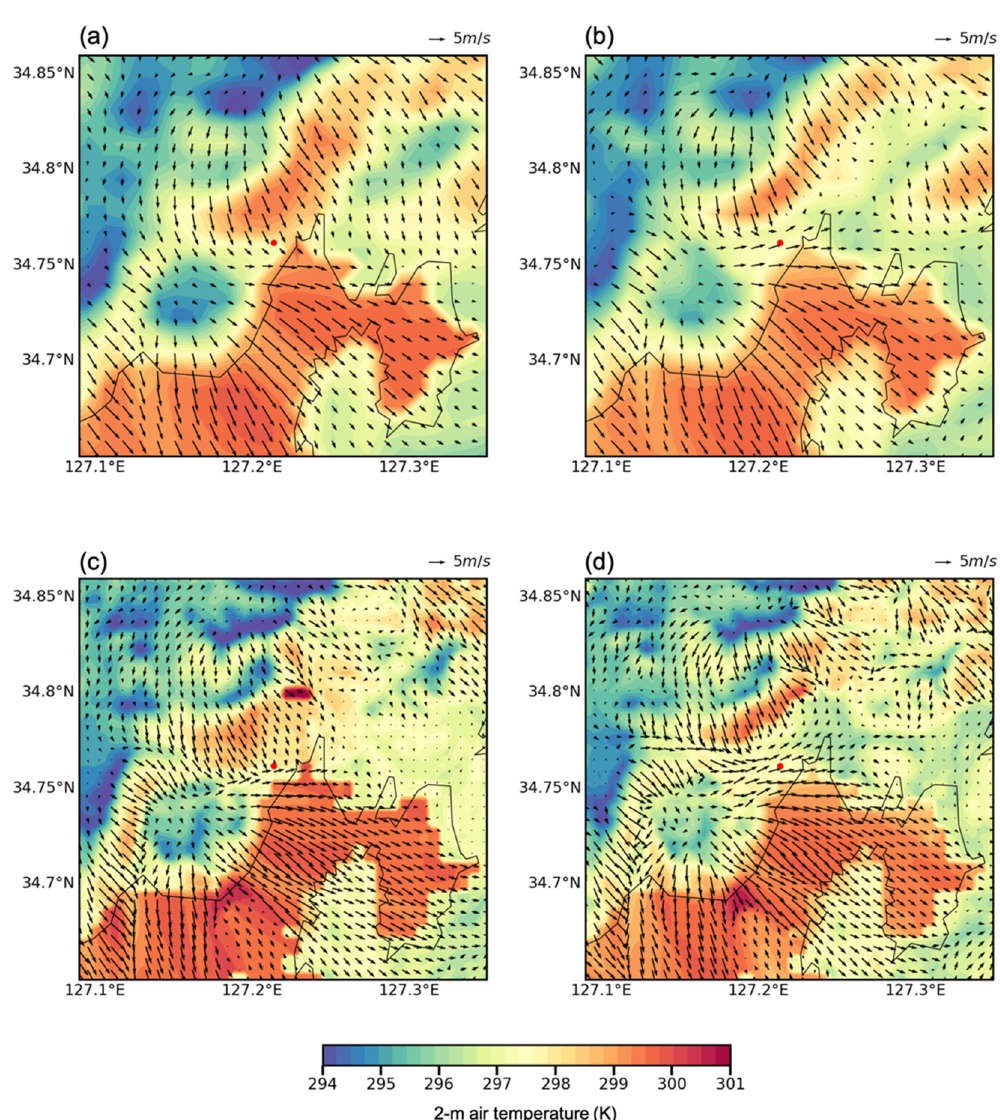
Figure 11. Horizontal distribution of 2-m air temperatures and 10-m wind vectors in the analysis domain at 05:30 LST: ( a ) S03, ( b ) S03V, ( c ) S04, and ( d ) S04V. Red dot: location of the BSWO.